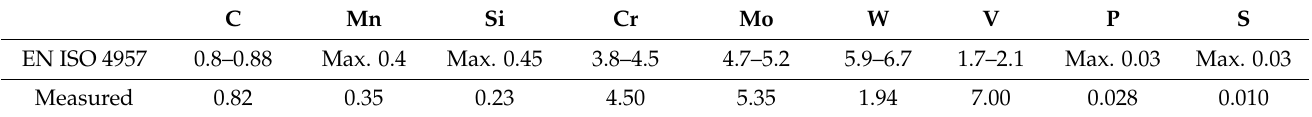
Table 2. HS6-5-2 steel chemical composition (weight